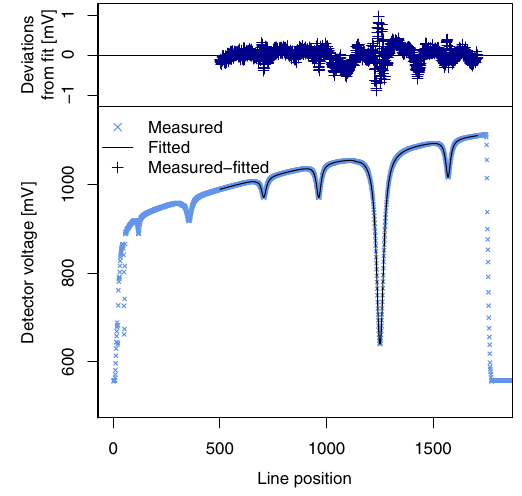
Figure 1. Measured and fitted spectrum, as exported from the in- strument’s operational software